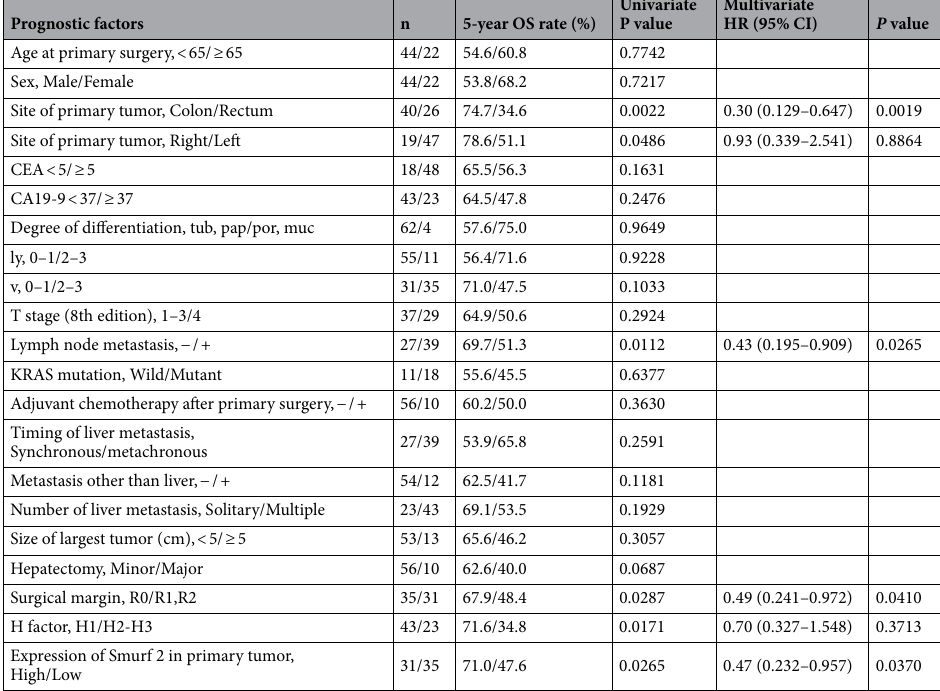
Table 2. Prognostic factors for overall survival (OS) in colorectal cancer. CEA, carcinoembryonic antigen; CA19-9, carbohydrate antigen 19–9; KRAS, Kirsten rat sarcoma viral